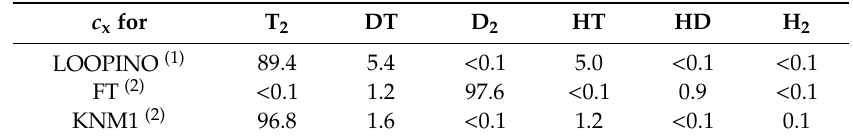
Table 3. Nominal hydrogen isotopologue concentrations (in percent) of the reservoir gas supplies used during the di ff erent measurement